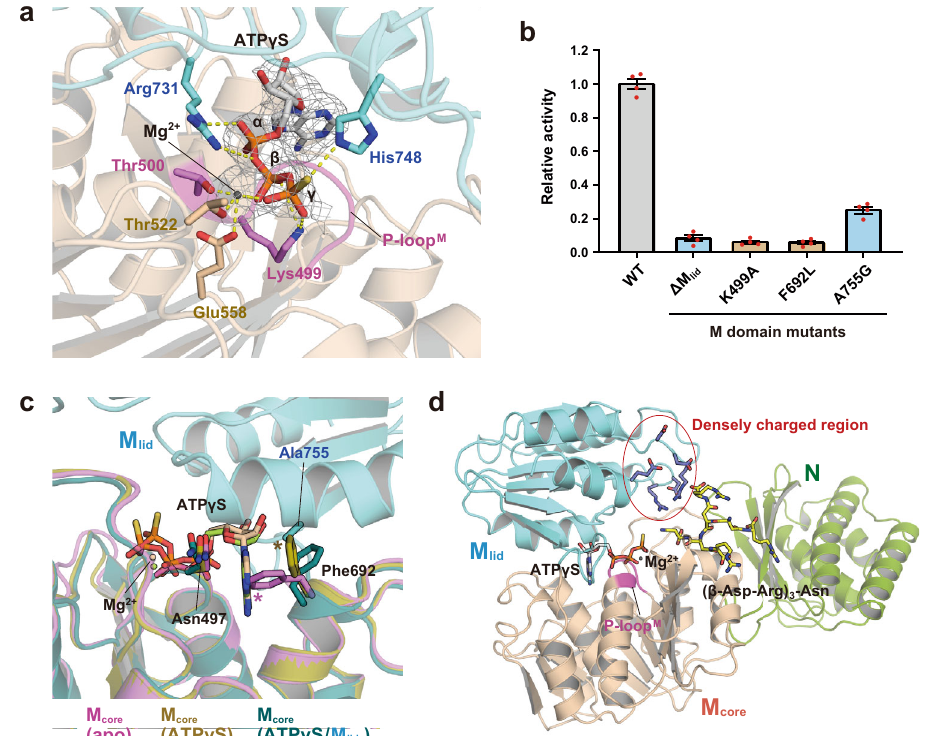
Fig. 4 |StructuralbasesofM lid forATP-dependentArgsidechaincondensation to cyanophycin. a Binding site of ATP γ S betweenM core (wheat) and M lid (cyan)on the surface of the M domain. The cryo-EMmap carved 2Å around Mg 2+ and ATP γ S atcontourlevel10.ThemagentastructureshowstheP-loop M .Hydrogenbondsand Mg 2+ coordinationareshownasyellowdashedlines. b Relativeenzymaticactivityof Te CphA1 (WT) and each M domain mutant, including the deletion mutant of M lid ( Δ M lid ). Enzyme activities were measured by detecting the released phosphates. Dataarepresentedasmean±standarderrorofthemean(SEM)( n